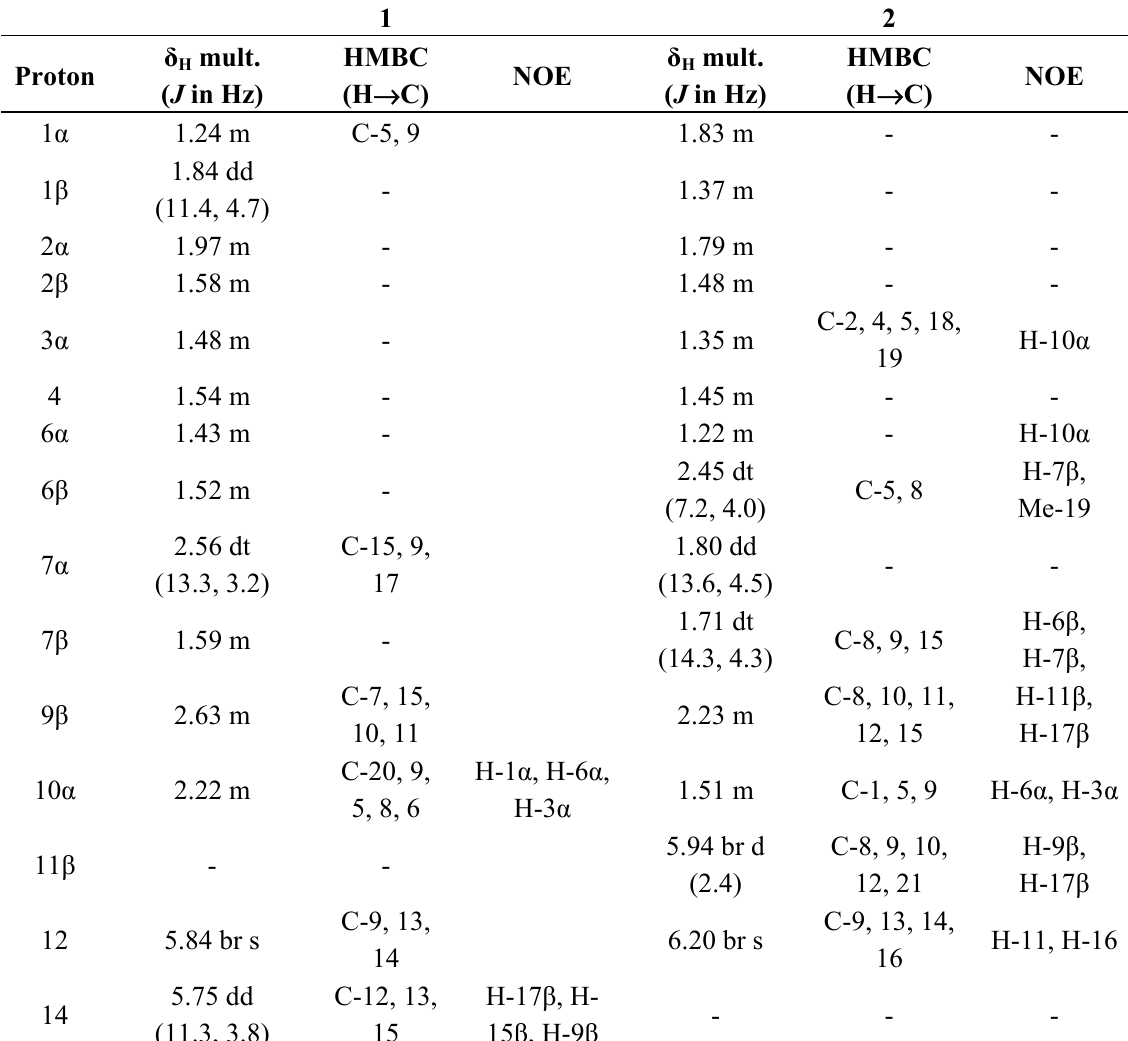
Table 1. 1 H-NMR data, HMBC and NOE correlations for compounds 1 and 2 in CDCl ( J in Hz in